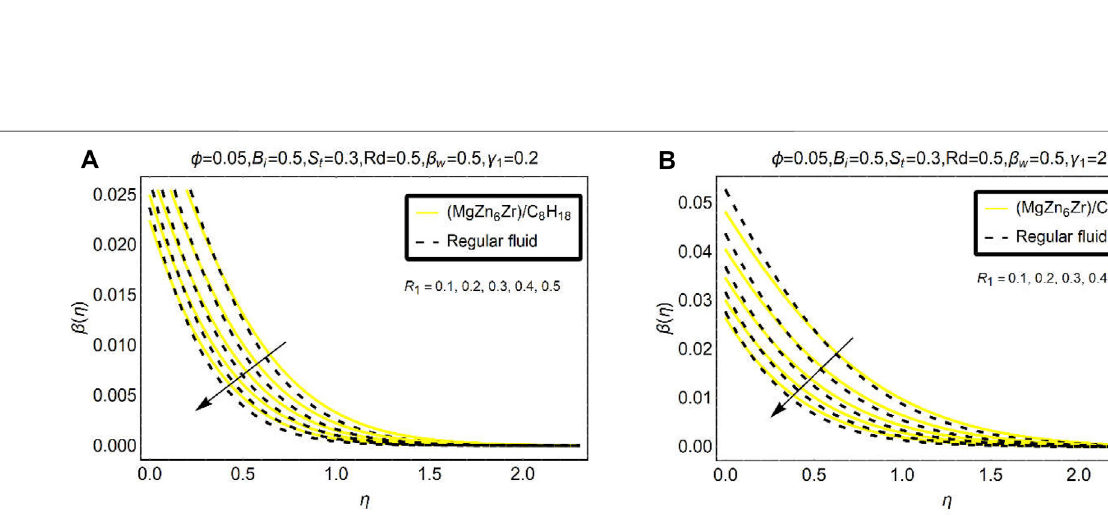
Frontiers in Energy Research |